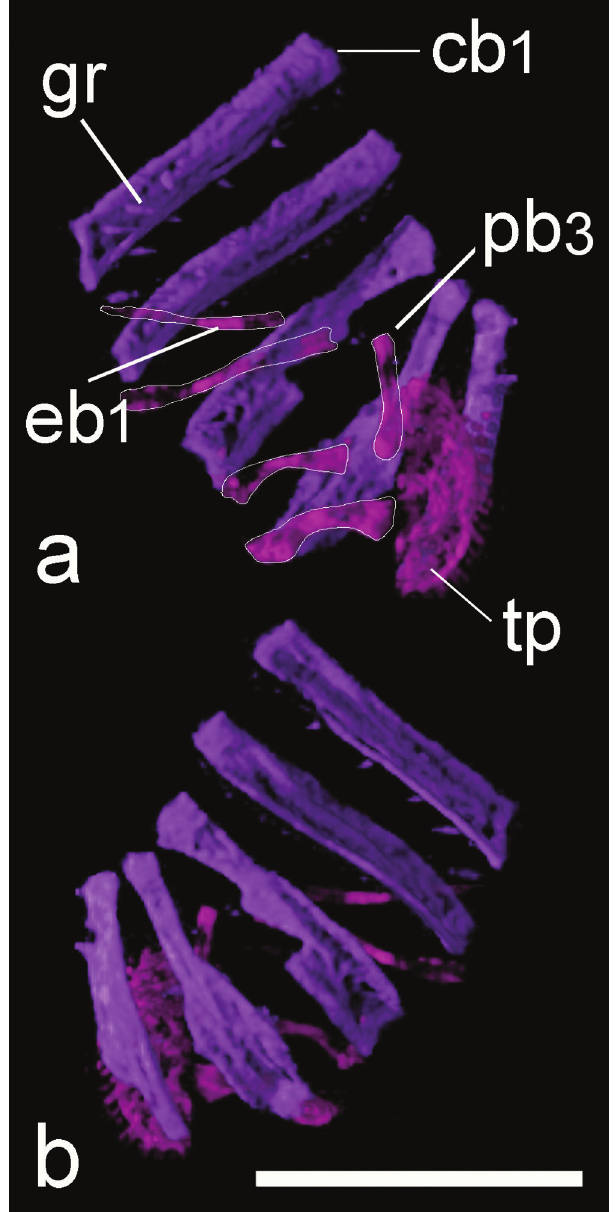
Fig. 7. HRXCT model of left branchial arches of Hoplomyzon cardosoi , MCNG 375, holotype, 18.5 mm SL. a. Dorsal view (anterior toward top). b. Ventral view. cb1: ceratobranchial 1; eb1: epibranchial 1; pb3: pharyngobranchial 3; tp: tooth plate. Margin of epibranchials and pharyngobranchial 3 highlighted in white. Scale bar = 1 mm. Sensory canals and associated structures . Nasal present, small and tubular positioned lateral to constricted portion of mesethmoid (Fig. 3a). Infraorbital 1 with anteriorly elongated arm curved medially, dorsal to premaxilla and second medially directed acute process on its dorsal surface. Infraorbital canal entering at medial margin of infraorbital 1 just posterior to medially directed process and exiting from posterior posterolateral surface of